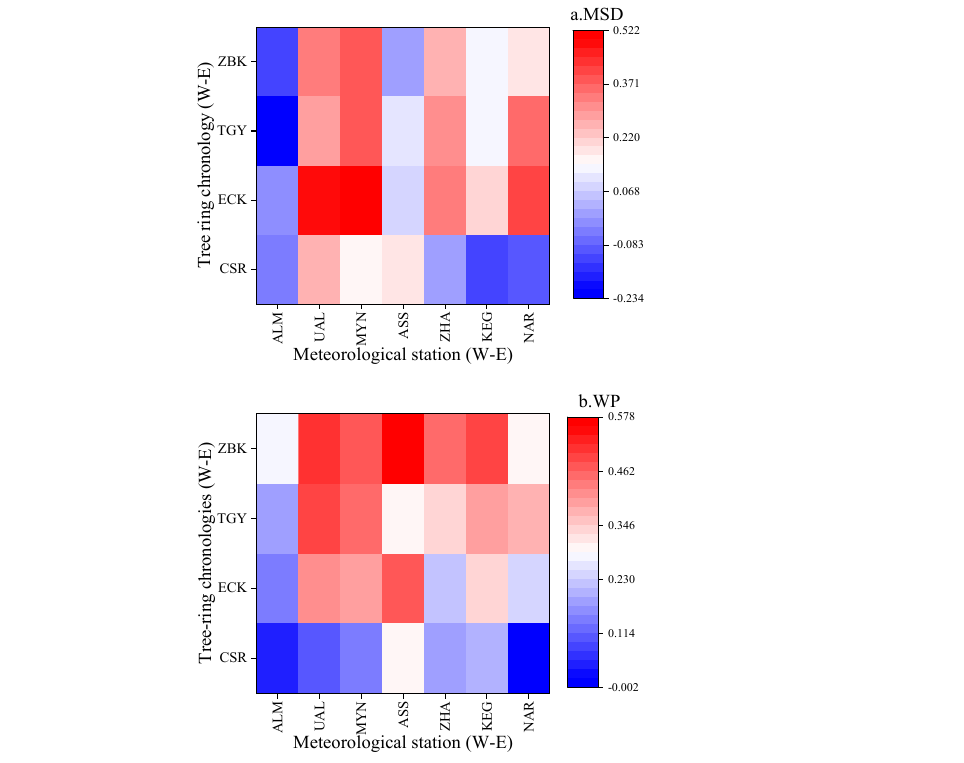
Figure 4. ( a ) Heat map of the correlations between the maximum snow depth and tree ring width in Kazakhstan (from west to east); ( b ) heat map of the correlations between the precipitation from previous November to current April and tree ring width in Kazakhstan (from west to east). MSD and WP represent maximum snow depth and winter snowfall, respectively.